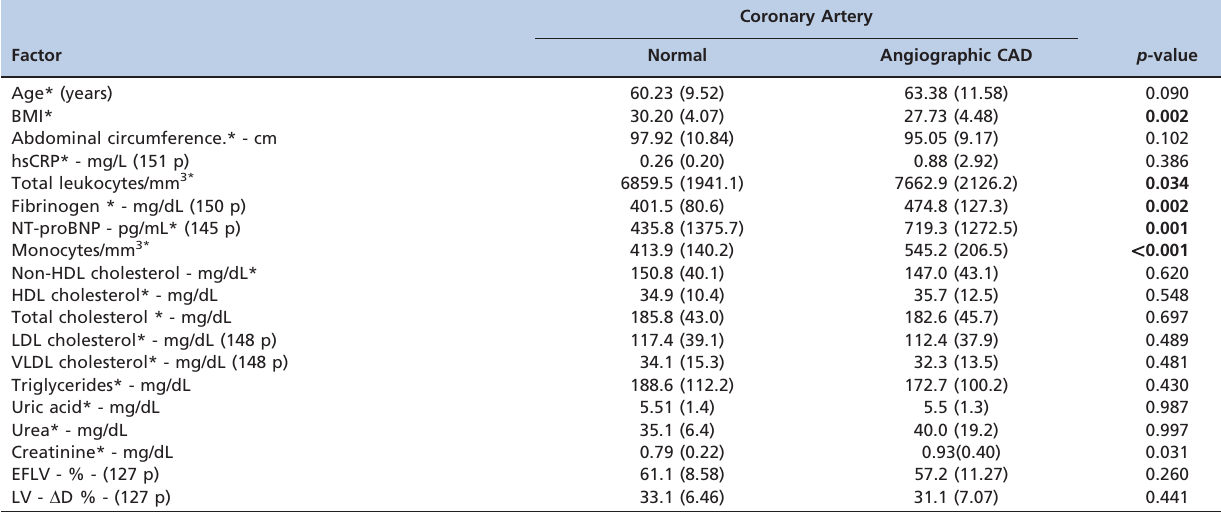
Table 5 - Comparison of Groups A and B with respect to quantitative